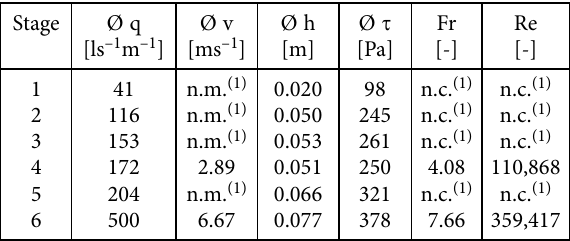
Table 3. Mean unit discharges (q), measured and computed hydraulic values (flow velocity (v), discharge depth (h), shear stress ( τ )), Froude & Reynolds numbers, unvegetated,